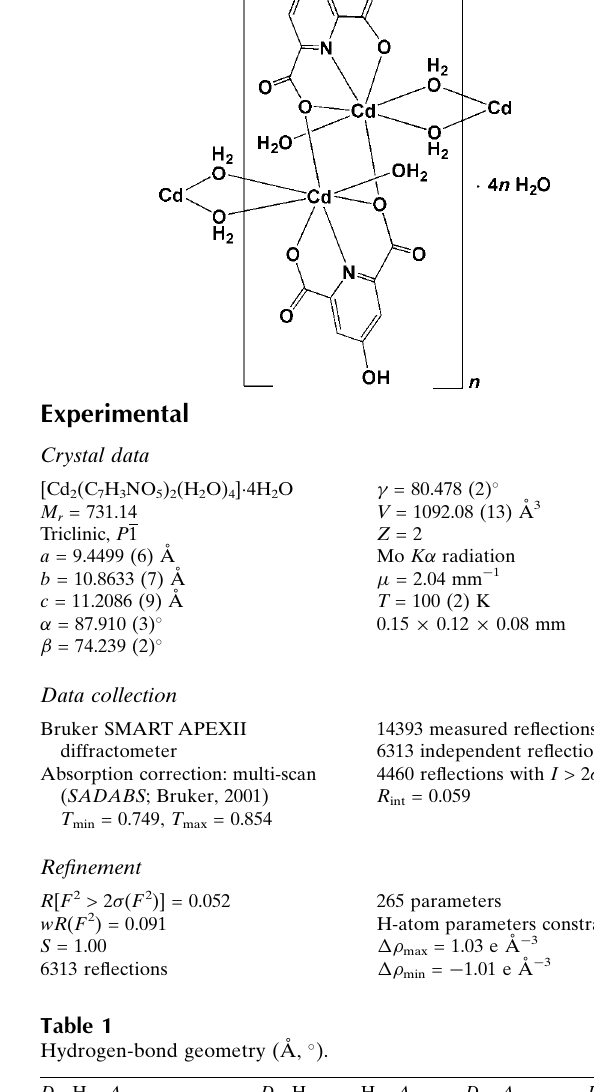
acid and propane-1,3- Bruker SMART APEXII